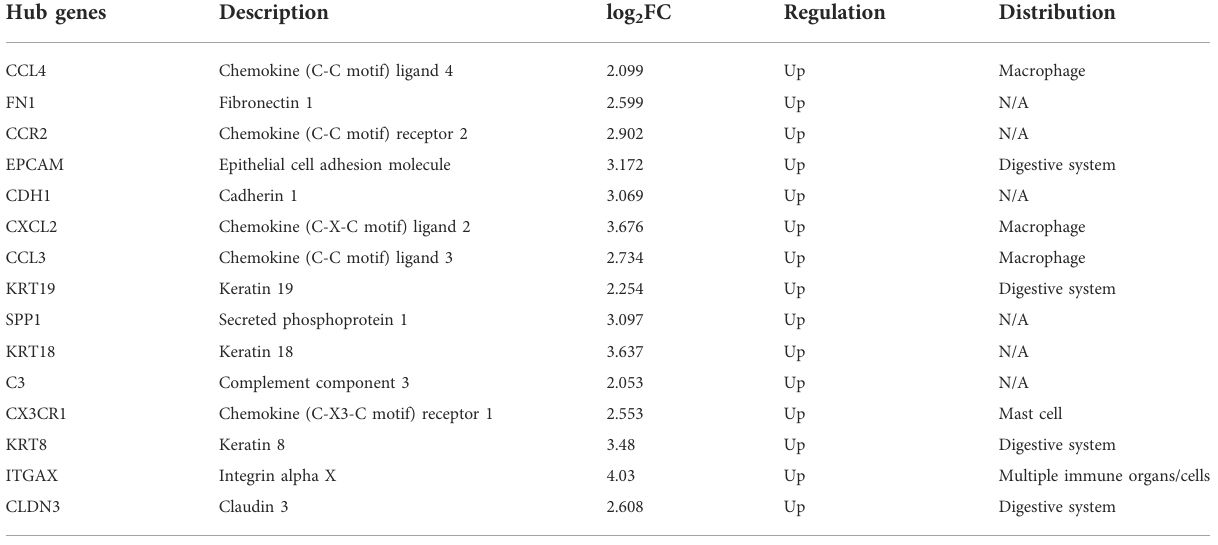
TABLE 3 15 hub genes identi fi ed by fi ve algorithms of cytoHubba.